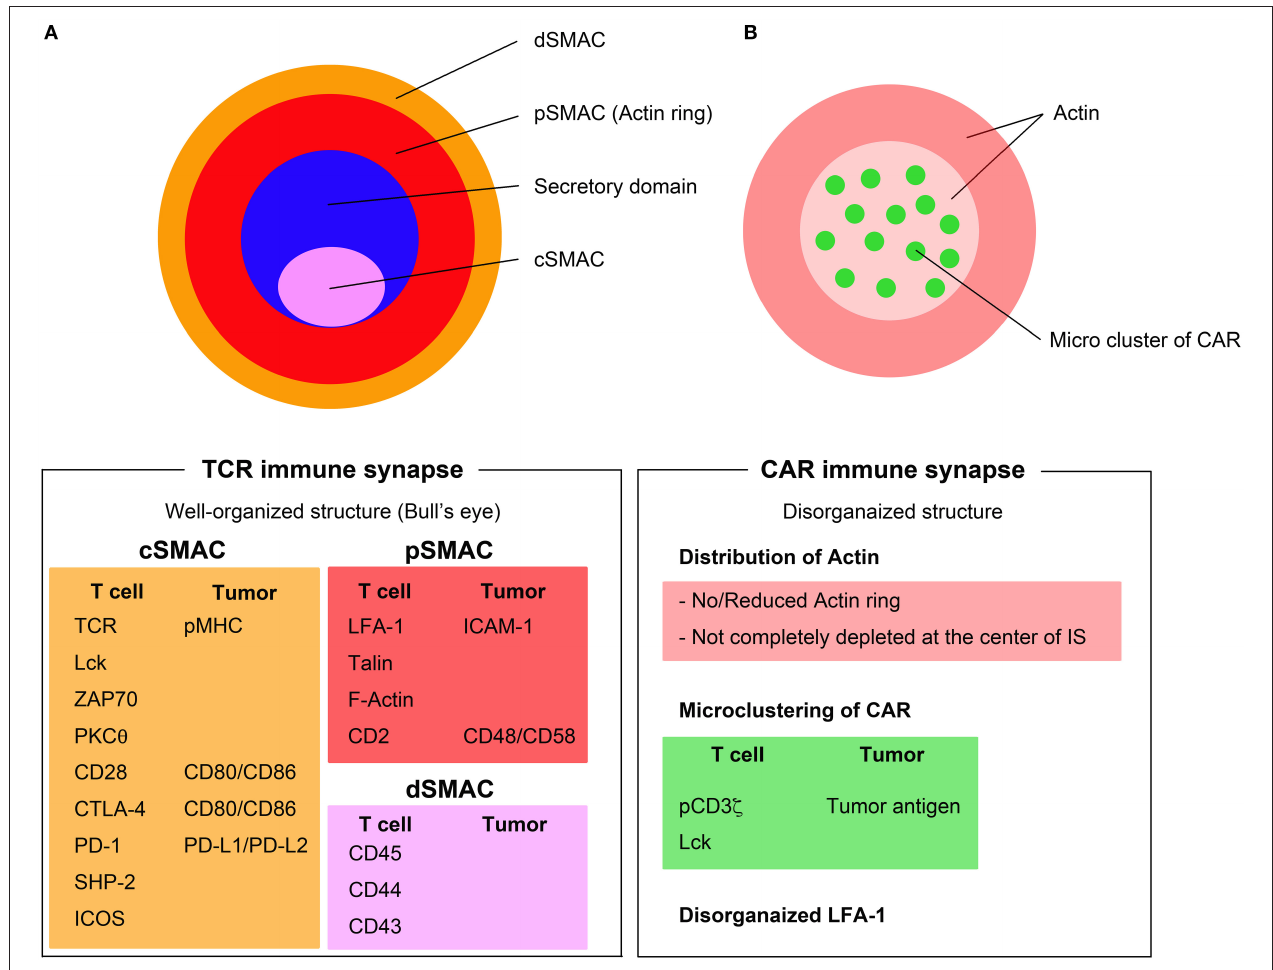
FIGURE 1 | Immunological synapse formation through TCRs and CARs. (A) TCR immune synapse shows a well-organized bull’s eye structure including the central supramolecular activation complex (cSMAC) (pink), the peripheral SMAC (pSMAC) (red), and distal SMAC (dSMAC) (orange). (B) CAR immune synapse (right) displays disorganized structure with no/reduced actin ring and microclusters of CAR/tumor antigen in a disorganized pattern. Major components of the TCR and CAR immune synapse are listed below the figures.